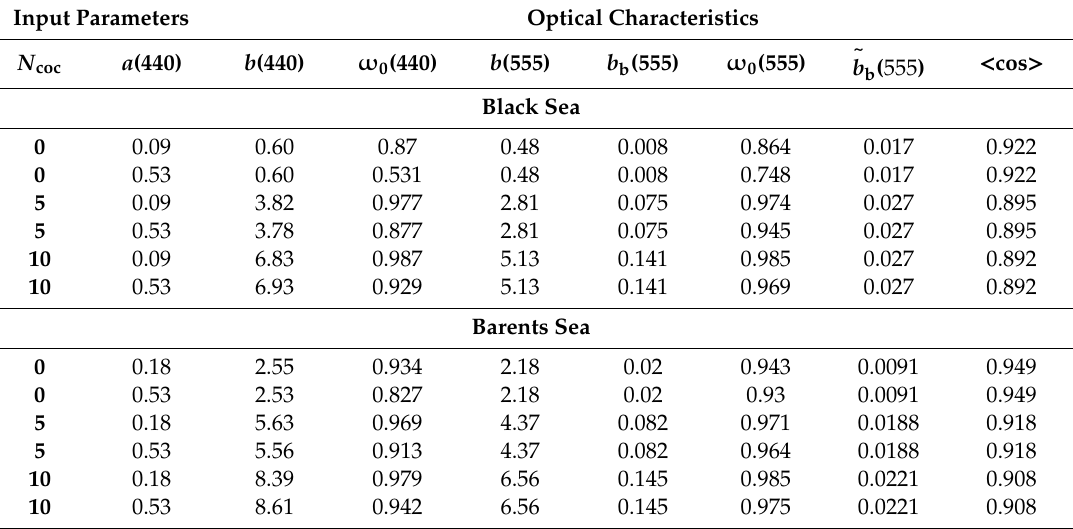
Table 2. Set of optical characteristics * for the